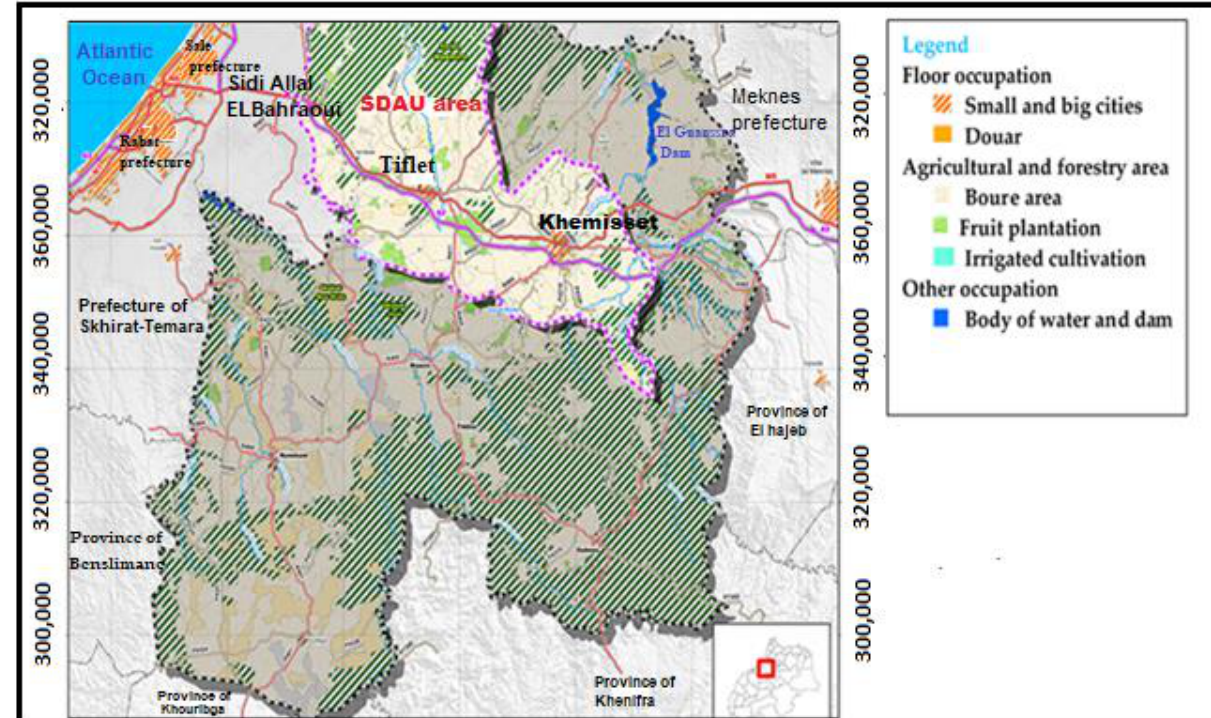
Figure 2. Land-cover map in the Khemisset – Tiflet area [11].